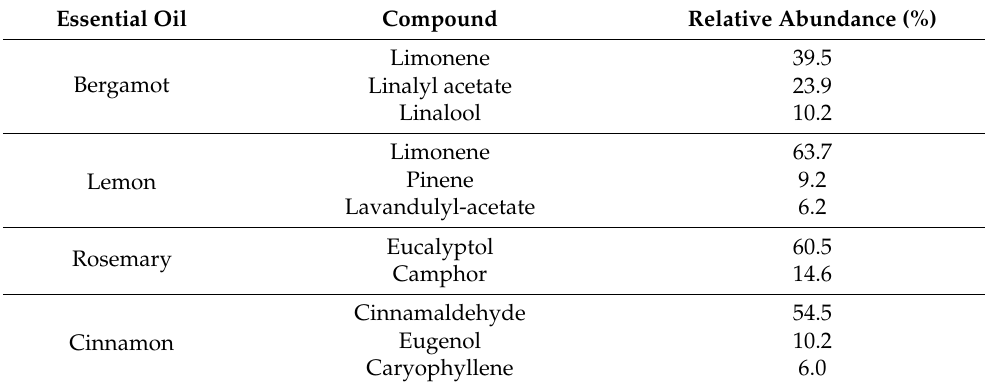
Table 2. Main components in bergamot, lemon, rosemary and cinnamon oils, obtained by GC-MS analysis. Components with relative abundance <5.0 % were not